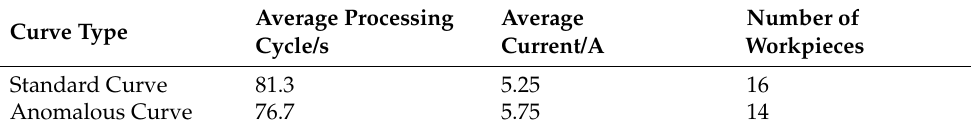
Table 6. Comparison of multiplier